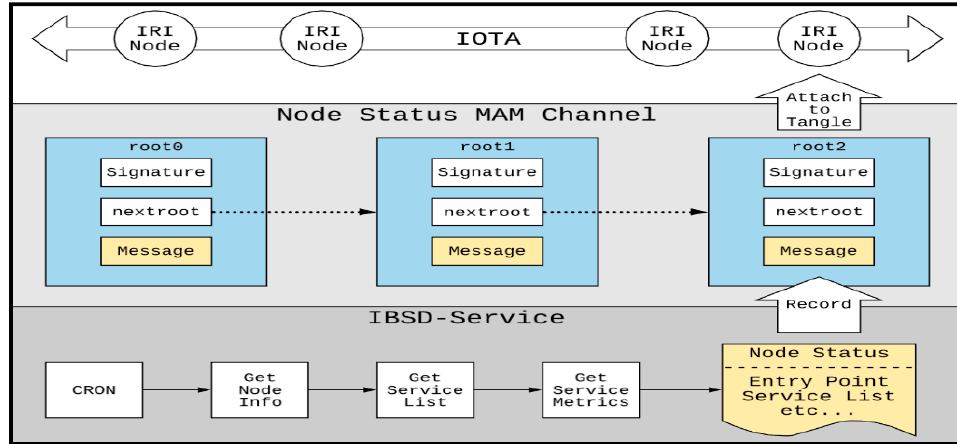
Figure 5. Node information releasing .